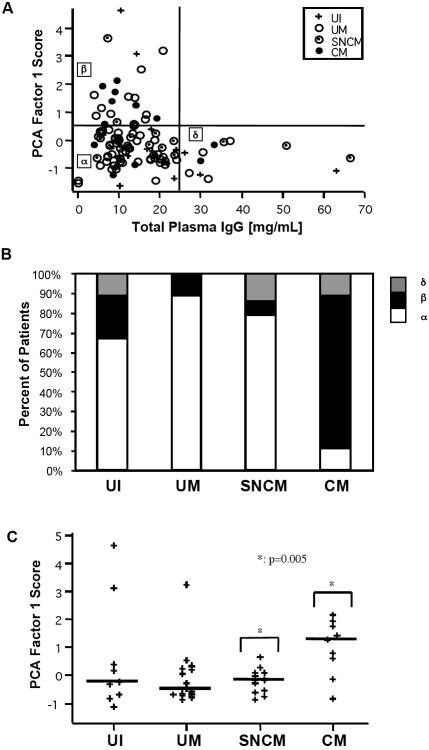
Properties of adjusted IgG anti-brain reactivity in terms of PCA factor 1 scores.A. Relationship to total plasma IgG concentration, and dissection into three subgroups : α (IgG<25 mg/ml; F1<0.5), β (IgG<25 mg/ml; F1>0.5), δ (IgG>25 mg/ml; F1<0.5). B. Frequencies of patients above one year of age in each group, over the three subgroups. C. Groupwise distribution of PCA factor-1 scores among patients older than one year, with horizontal bars indicating median values. The significance of the difference between patients with CM and with non cerebral clinical malaria (UM+SNCM) is indicated.